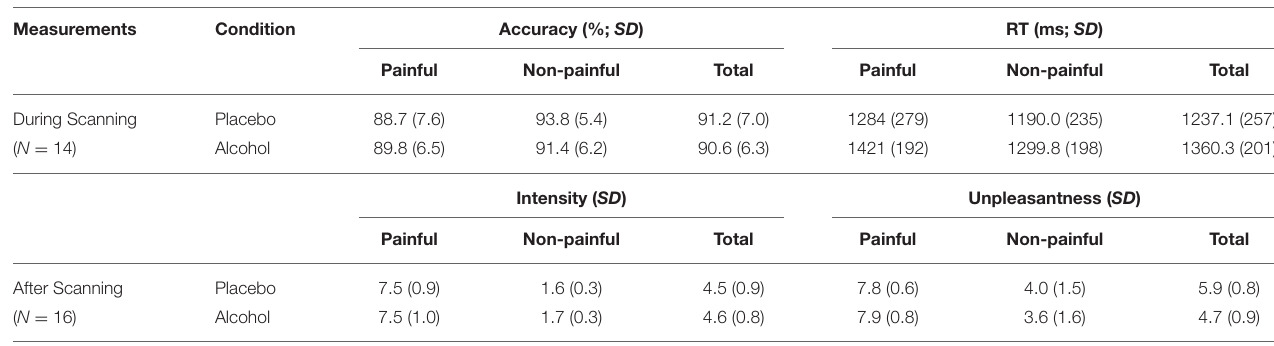
TABLE 2 | Average behavioral performance during and after fMRI scanning.